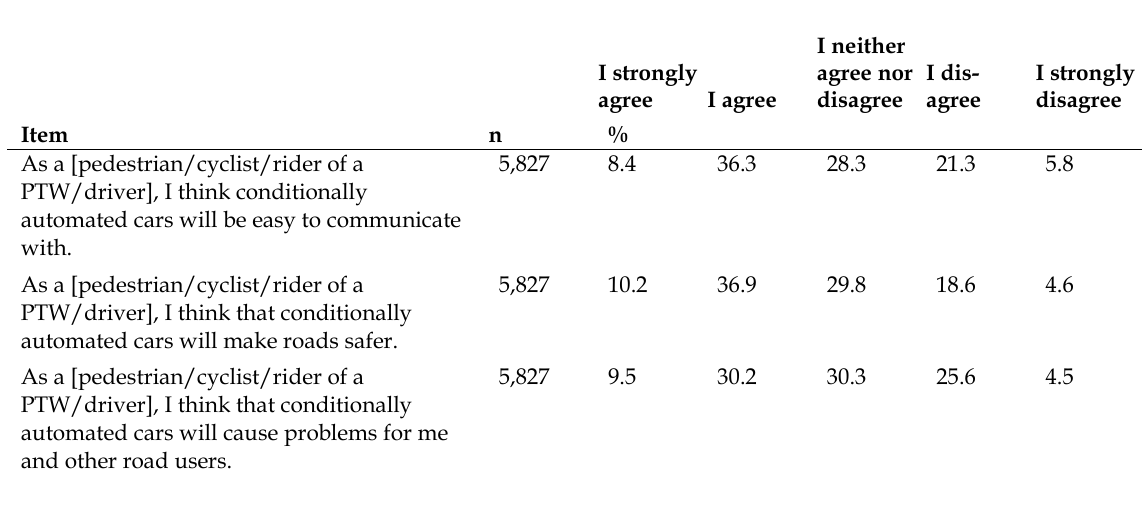
Items and descriptive statistics for measurement of the road user acceptance